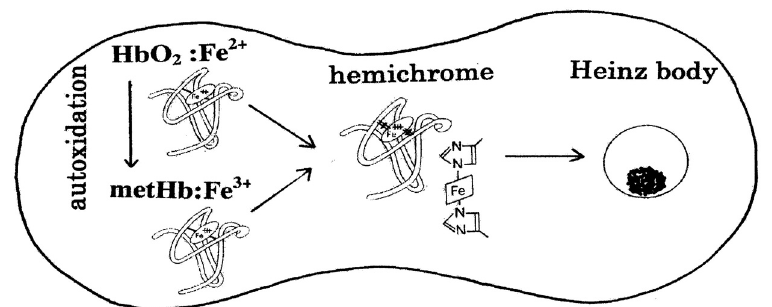
Figure 21. Schematic representation of the role of the α HbO A, redrawn from Sugawara et al. [24]. The α 2 conformational constraint in the constituted chains via tilting of the distal His (E7) residues so as to cause degradation of the Hb molecule to hemichrome, and subsequent Heinz-body clustering within the erythrocyte. In the spleen (which is responsible for the removal of aged and damaged red cells from the blood circulation), Heinz body-containing red cells become trapped and hence undergo hemolysis. By virtue of this endowment, Hb molecules control the fate (removal) of their own erythrocytes from the blood circulation depending on internal and extraneous circumstances, including pH and